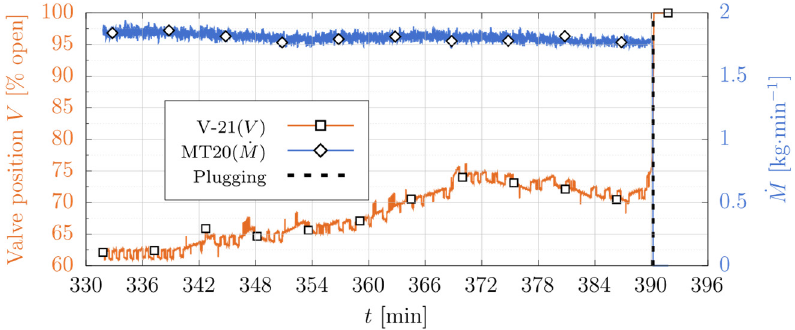
Figure 5. Pressure (PT10) and temperature (TT13) measurements in SV02 during the pressure reduction at the end of Experiment 2.